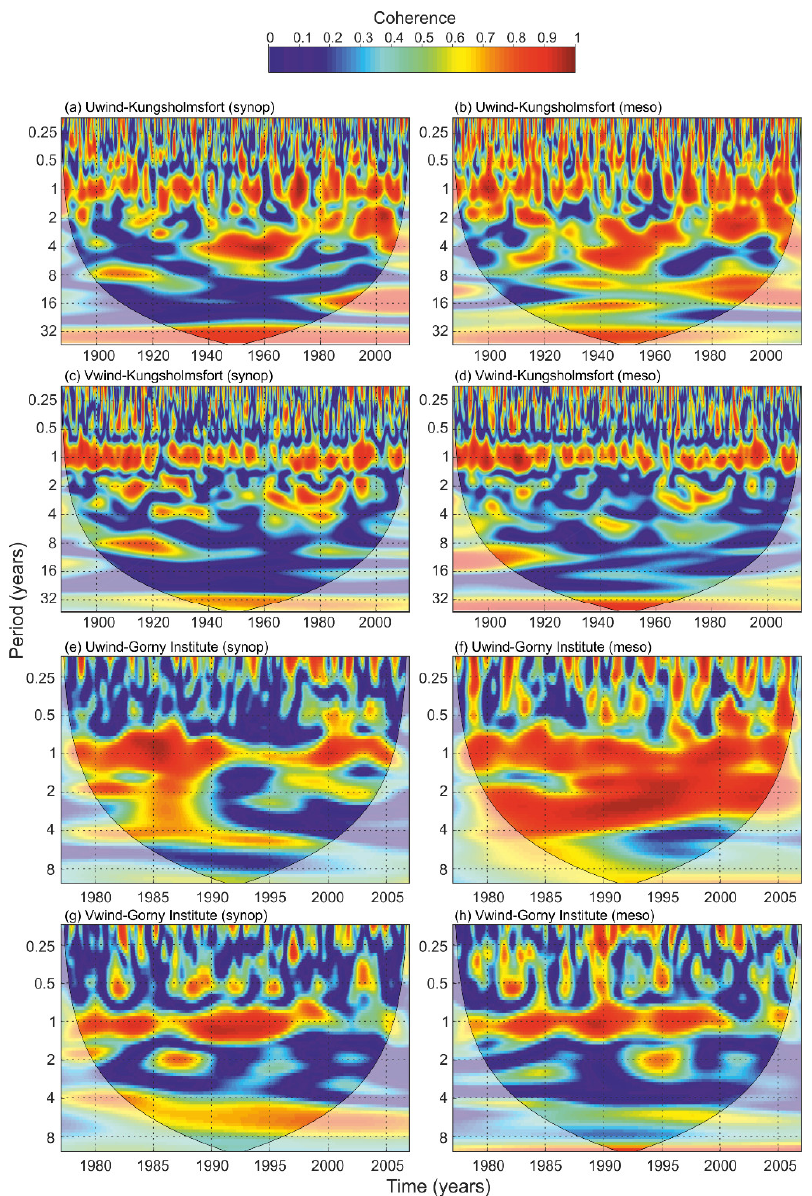
Figure 11. Wavelet coherence of wind speed from the 20th Century Reanalysis mean monthly values of ( a , b , e , f ) zonal and ( c , d , g , h ) meridional components of with ( a , c , e , g ) σ 2 syn , ( b , d , f , h ) σ 2 mes at ( a – d ) Kungsholmsfort and ( e – h ) the Gorny Institute. Contours are wavelet squared coherencies. In all panels, the black thin line and the lighter shaded picture shown the cone of influence of the edge effects where might distort the